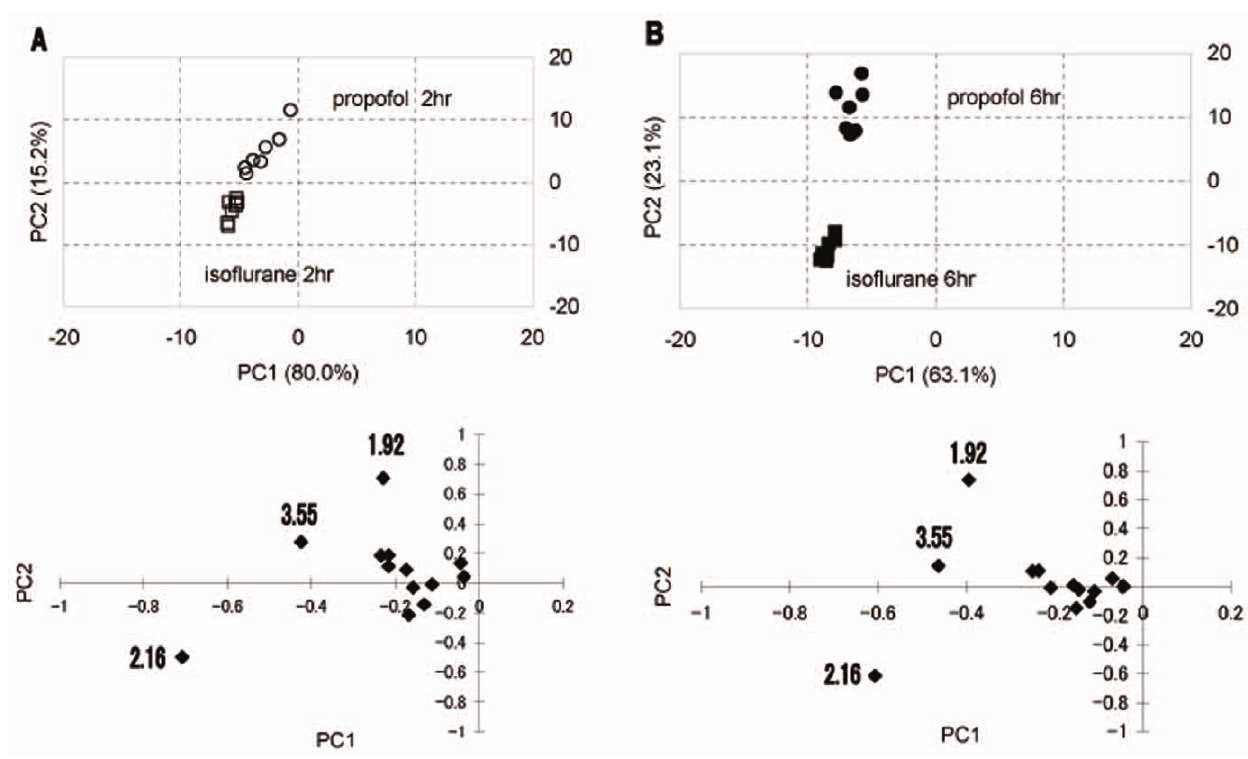
N Figure 3. PCA score plot of hydrophilic brain extracts. Each mark represents the metabolic data set from an individual rat. (A) Propofol 2 h ( # ) ) and isoflurane 6 h ( & ). Variables (n=15 reduced from 177). The lower graphs are PC loading plots of and isoflurane 2 h ( % ). (B) Propofol 6 h ( individual data sets to distinguish single putative NMR peaks responsible for the clustering pattern observed in the PCA score plot.